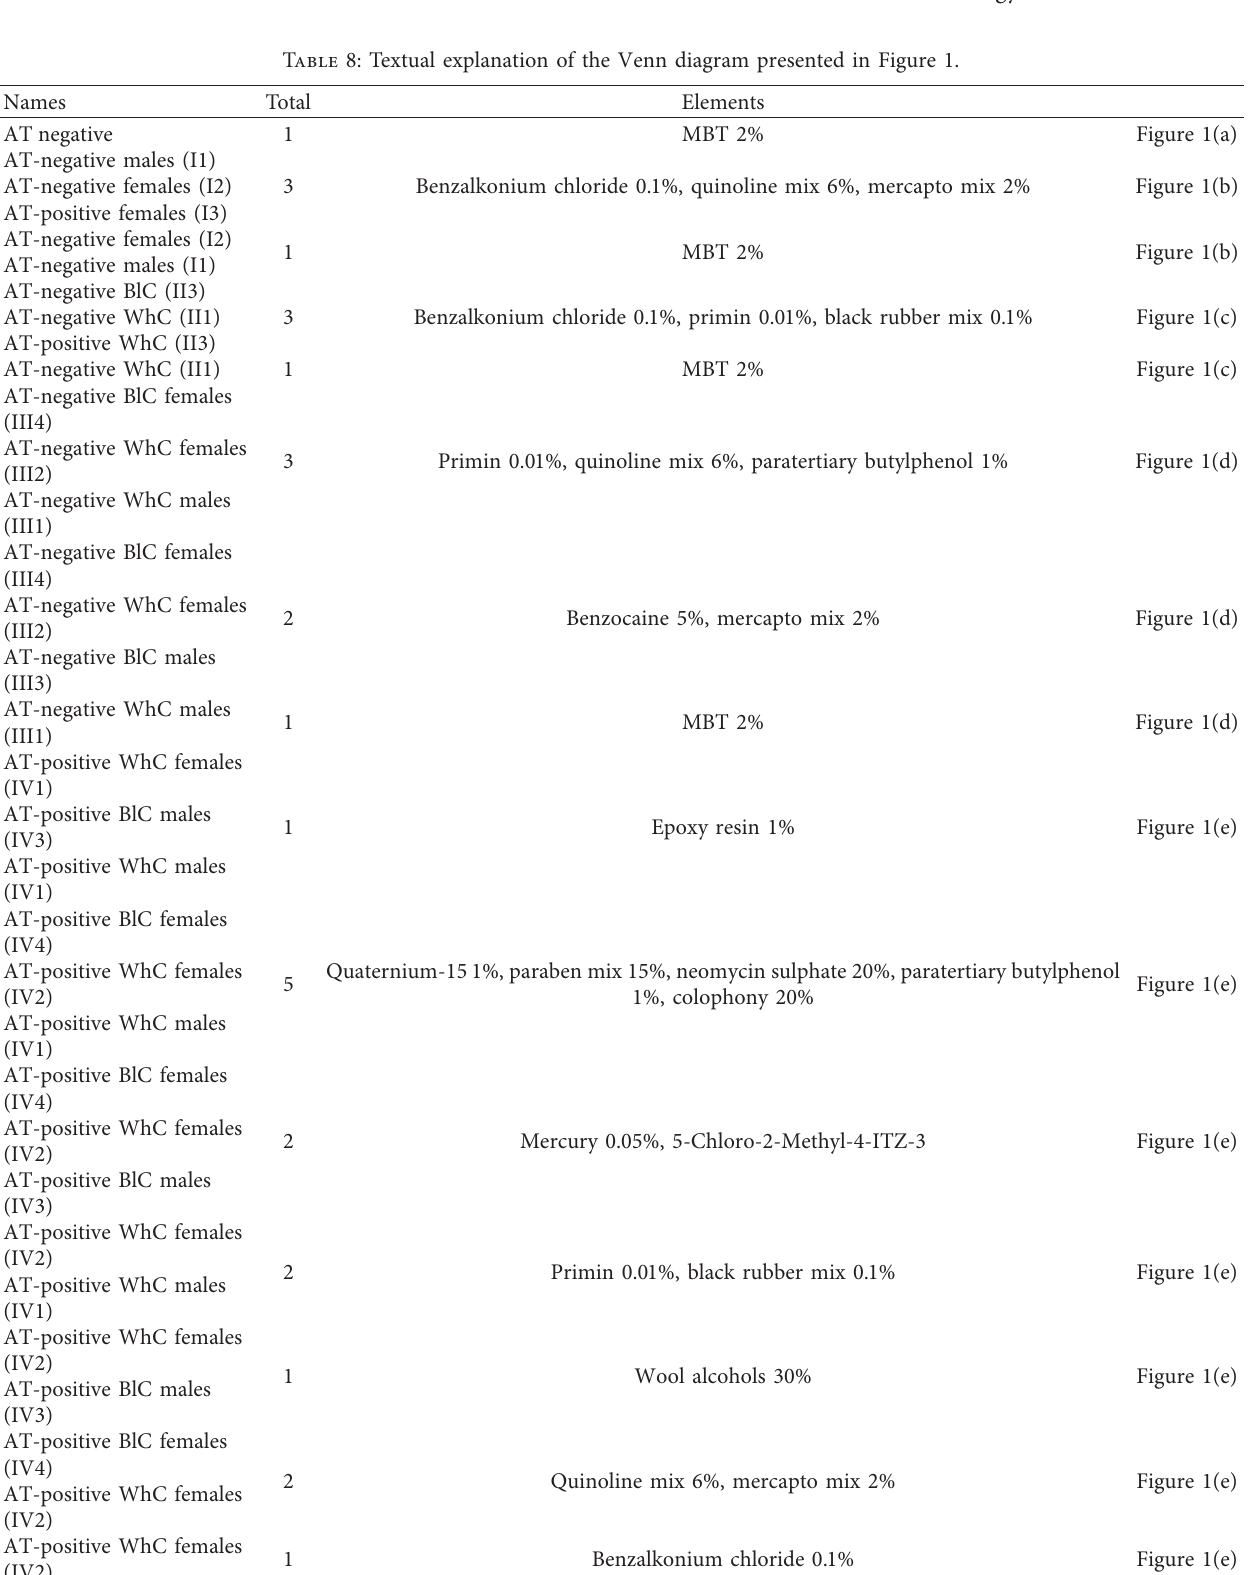
Table 8: Textual explanation of the Venn diagram presented in Figure 1.